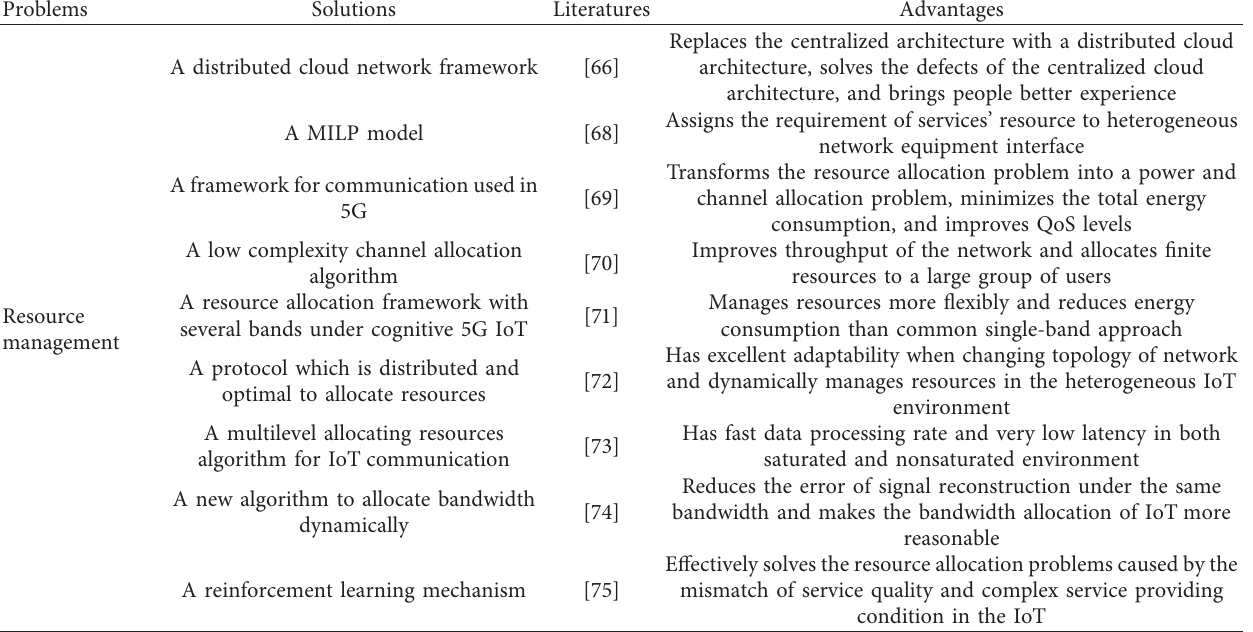
Table 4: Work summary of resource allocation and management in